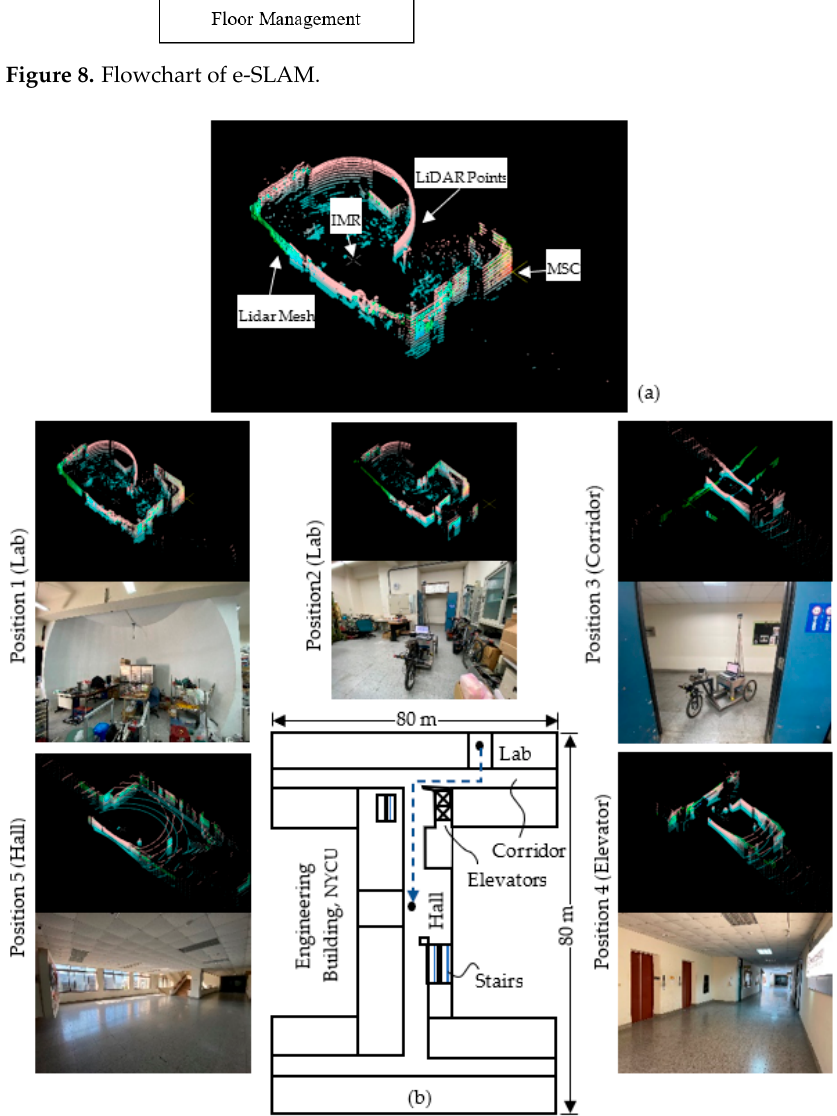
Figure 9. The LiDAR-based localization: ( a ) LiDAR data, ( b ) floor map and LiDAR map.